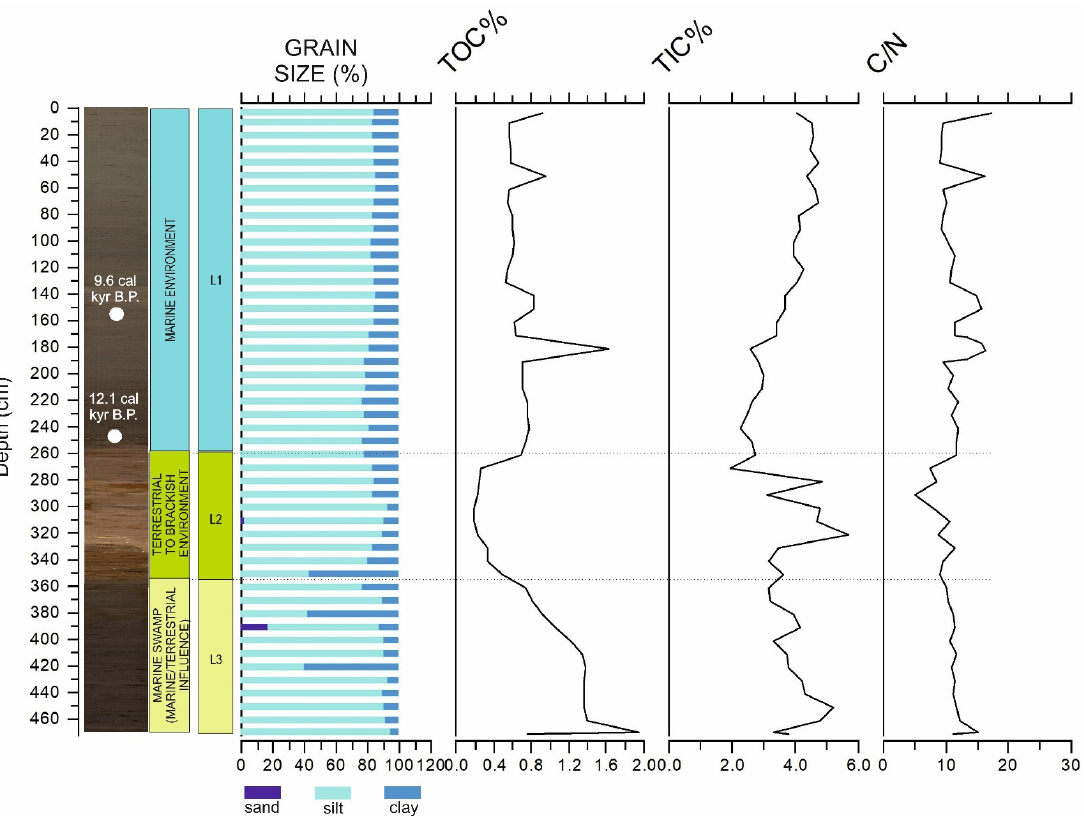
Figure 11. Sediment core KK-1 and lithological units in correlation with a variability of grain size, TOC, TIC and C/N ratios.